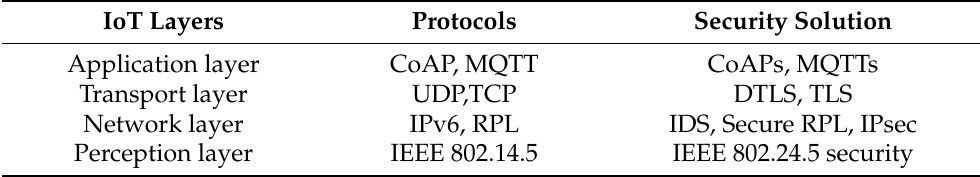
Table 2. IoT stack based on the standardised security